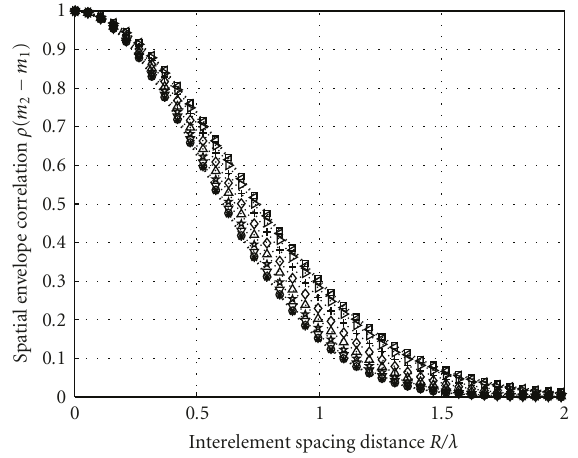
(b) Spatial correlation for a constant mean azimuth ϕ o = 30 ◦